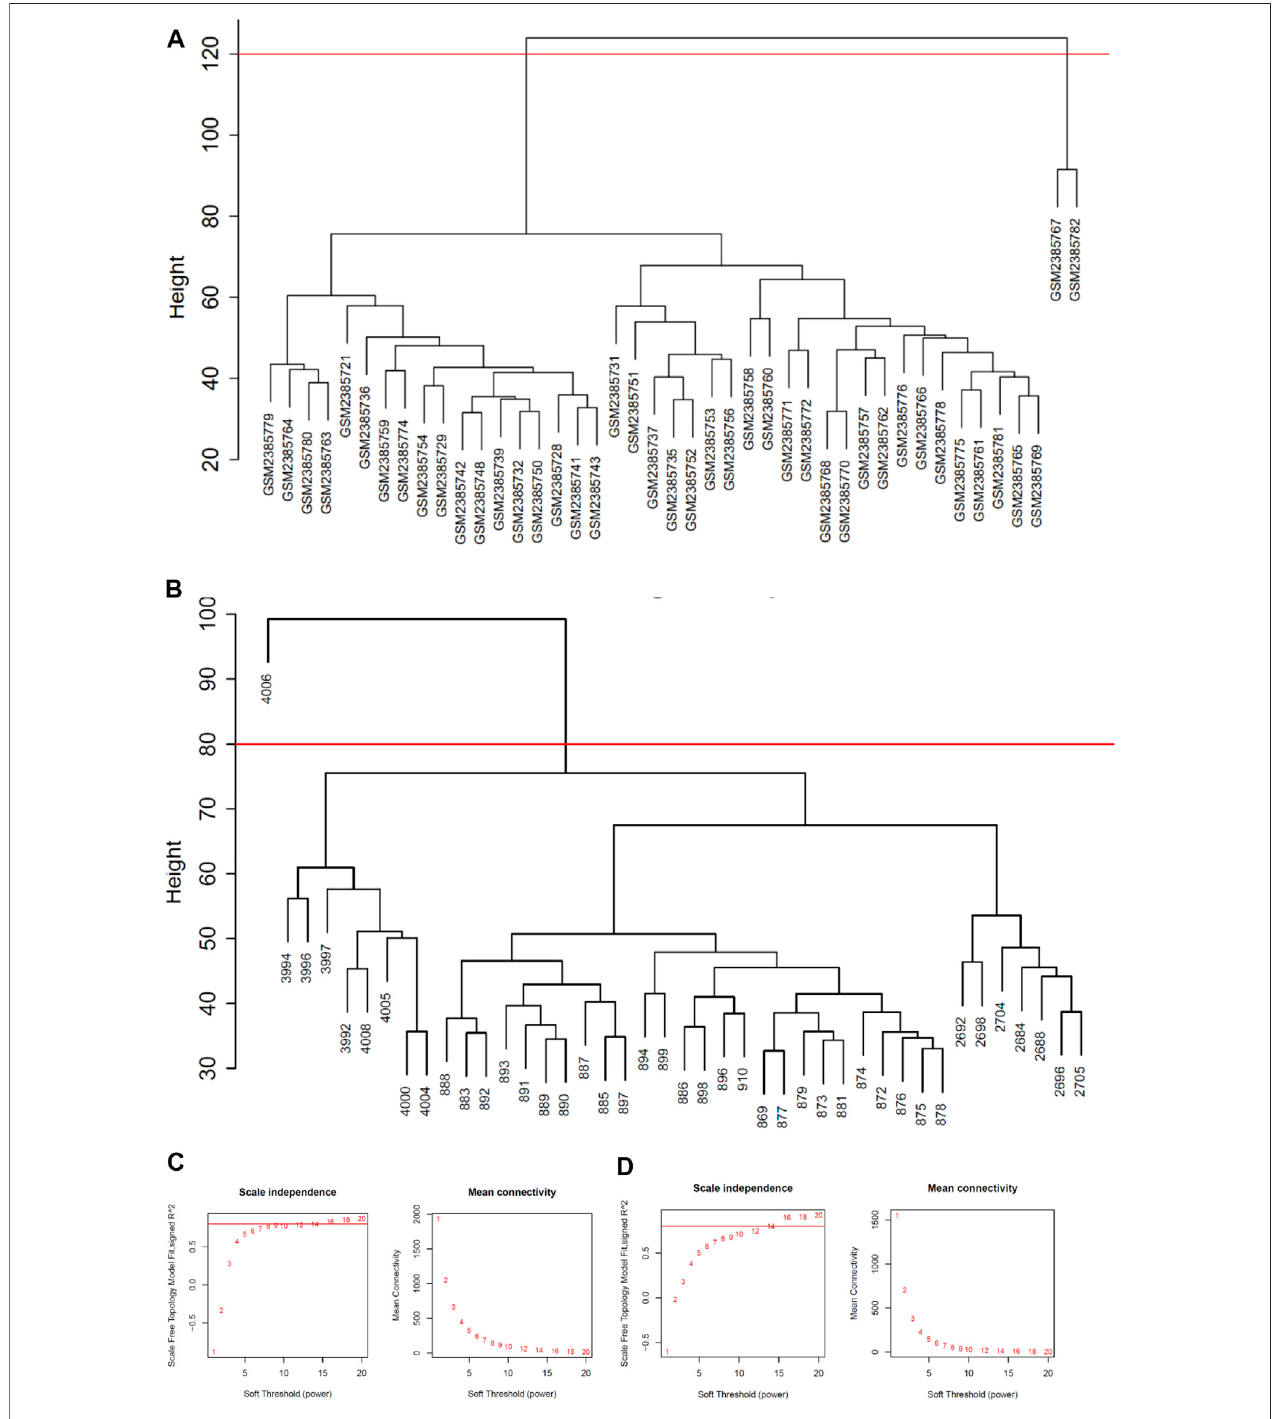
FIGURE 2 | Data processing before WGCNA analysis. (A) Removal of outlier samples from GSE89632. (B) Removal of an outlier sample from GSE126848. (C) Soft-thresholding calculation of GSE89632; Left: scale-free fi t indices using various soft-thresholding powers; Right: mean connectivity using various soft-thresholding powers. (D) Soft-thresholding power calculation of GSE126848; Left: scale-free fi t indices using various soft-thresholding powers; Right: mean connectivity using various soft-thresholding powers.